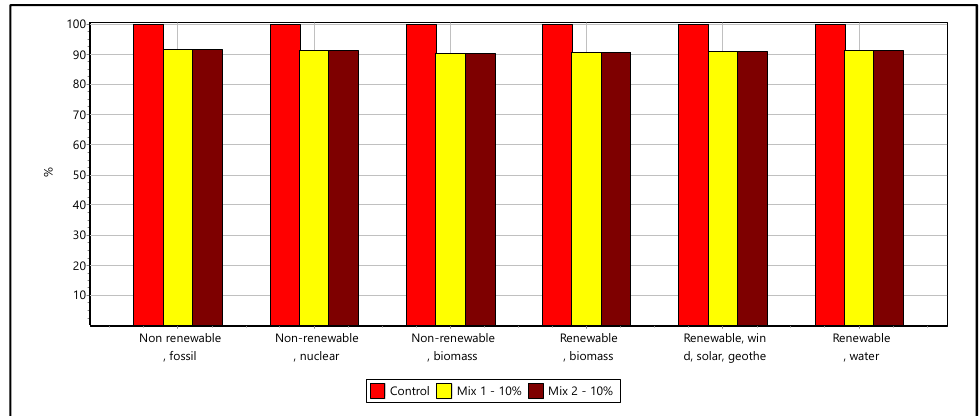
Figure 12. Energy demand analysis of secondary material cement replacement within the life cycle of the concrete mixes.